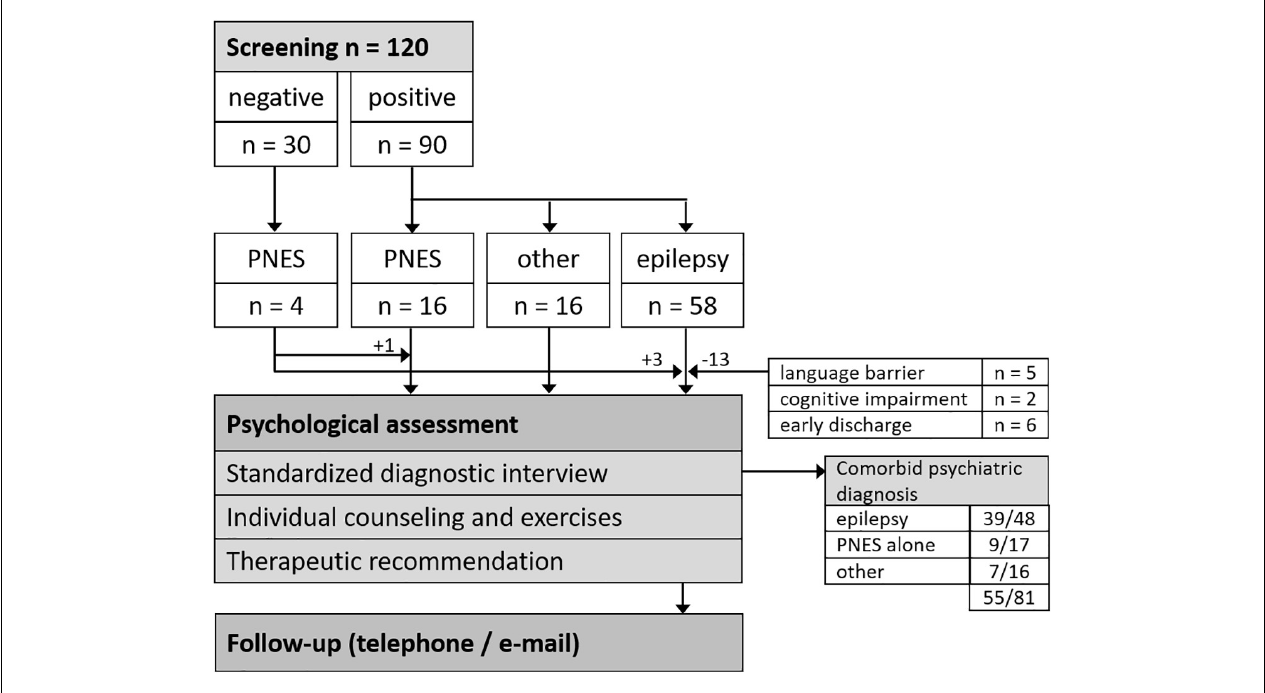
FIGURE 1 | Patient flow chart. PNES, psychogenic non-epileptic